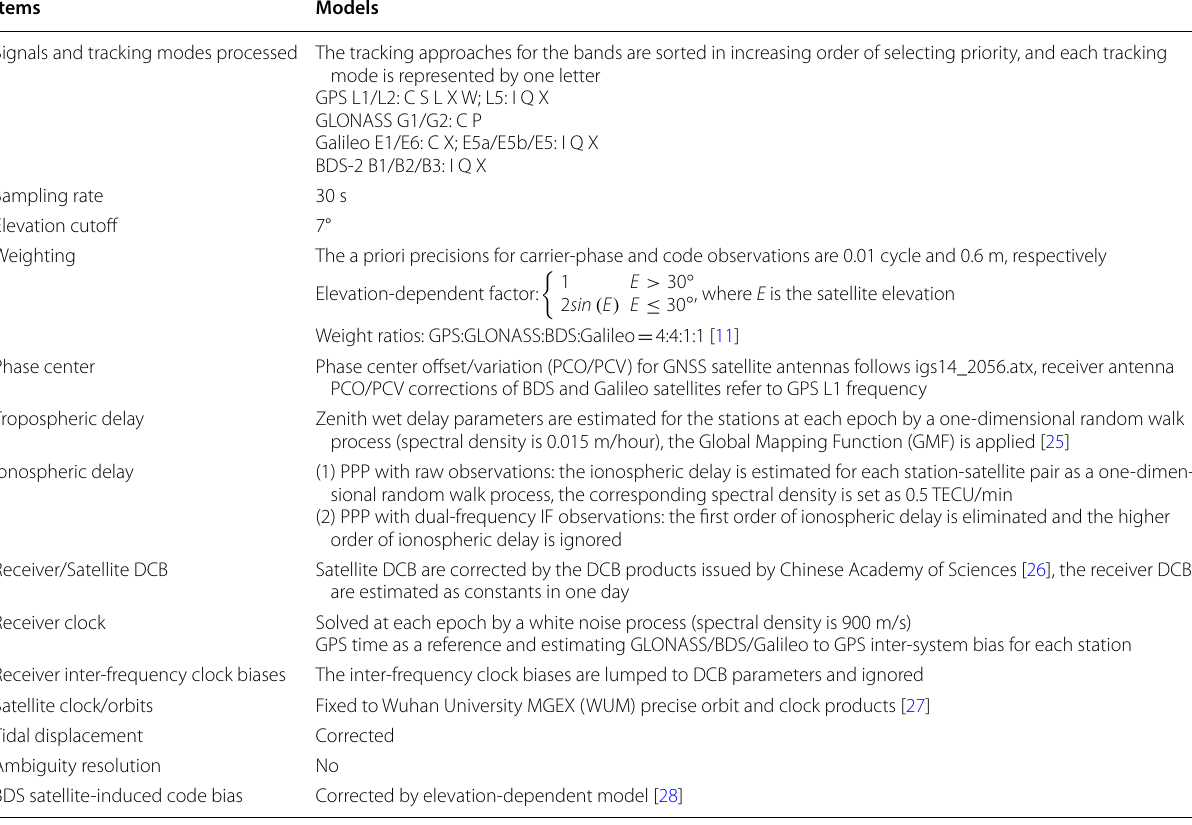
Table 1 Processing strategies in multi-constellation GNSS PPP Items Models Signals and tracking modes processed The tracking approaches for the bands are sorted in increasing order of selecting priority, and each tracking mode is represented by one letter